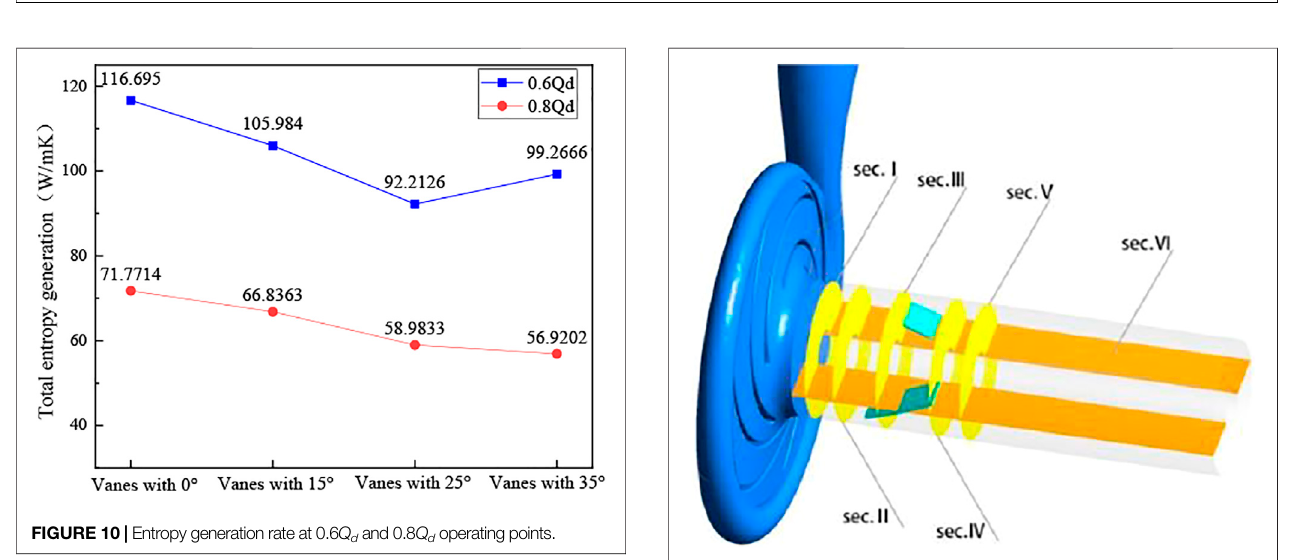
FIGURE 9 | Local EGRs and vortex cores of the centrifugal pump with vanes of different offset angles: (A) 0.6 Q d and (B) 0.8 Q d .